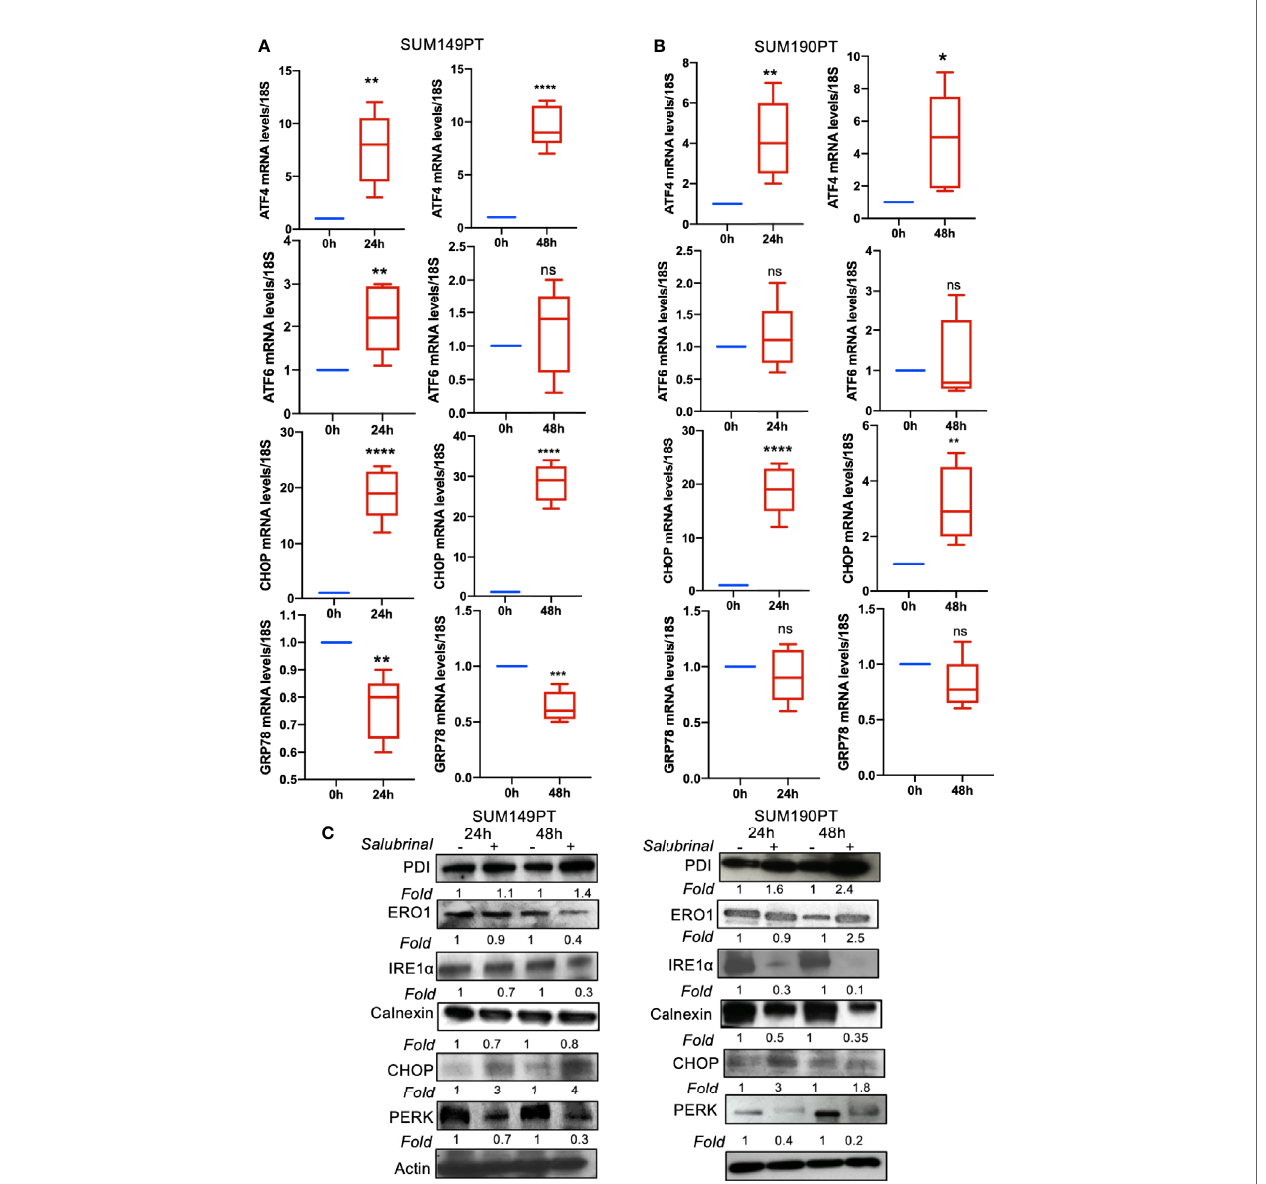
FIGURE 5 | Effect of Salubrinal treatment on ER stress gene expression levels in IBC cell lines. IBC cell lines (A) SUM149PT and (B) SUM190PT were cultured with or without 10 m M Salubrinal for 24 and 48 hours. RNA was prepared from SUM149PT and SUM190PT cells. RNA was converted to cDNA, and ER stress markers ATF4, ATF6, CHOP, and GRP78 were quantitated using real-time PCR, as mentioned in the methods section. Each point represents the average ± the standard deviation of three experiments. (*), p<0.05, (**) p<0.01, (***) p<0.005, (****) p<0.001 indicate a statistically signi fi cant difference compared with cells treated for 0h. ns, not signi fi cant. (C) Effect of Salubrinal treatment on ER protein levels in IBC cell lines. IBC cell lines SUM149PT and SUM190PT were cultured with or without 10 m M Salubrinal for 24 and 48 hours. Lysates prepared from SUM149PT and SUM190PT cells were tested for protein levels of ER stress markers ERO1 a , PERK, PDI, CHOP, IRE1 a calnexin using Western blot analysis. Blots were reprobed with anti- b -actin antibody as a loading